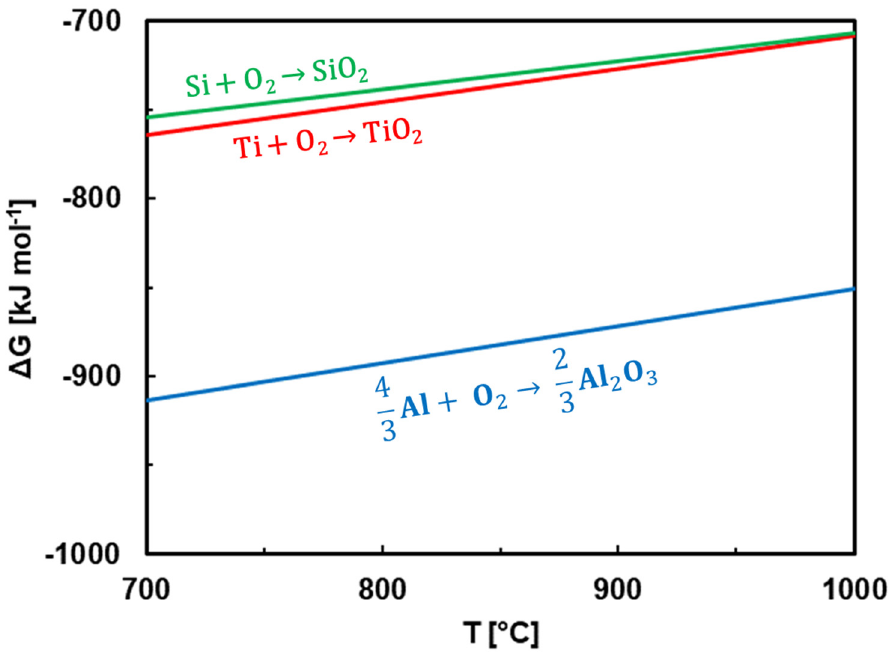
Figure 9. Gibbs free energies of formation of SiO 2 , TiO 2 and Al 2 O 3 .